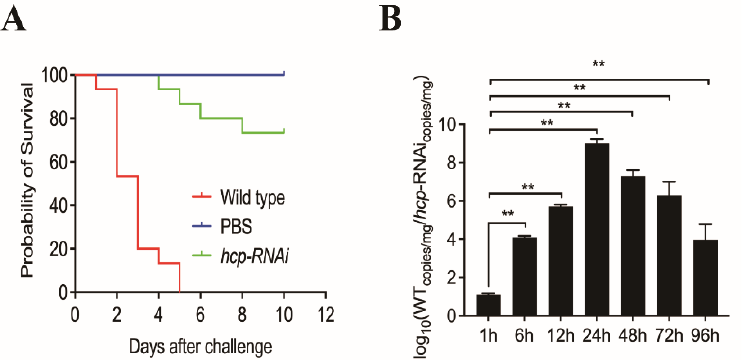
Figure 5. Effects of hcp gene silencing on the pathogenicity of A. salmonicida . ( A ) To assess the importance of hcp to A. salmonicida pathogenesis, E. coioides were infected with A. salmonicida wild-type and hcp -RNAi strains. The number of E. coioides that survived after infection with the indicated strains was compared ( n = 3). ( B ) The bacterial burdens of A. salmonicida wild-type and hcp -RNAi in E. coioides spleens were measured by quantitative real-time PCR (qRT-PCR) at 1, 6, 12, 24, 48, 72, and 96 hpi. The temporal dynamic distribution of A. salmonicida in E. coioides spleens was compared. Data are shown as mean ± SD from three independent biological replicates. ** p < 0.01.